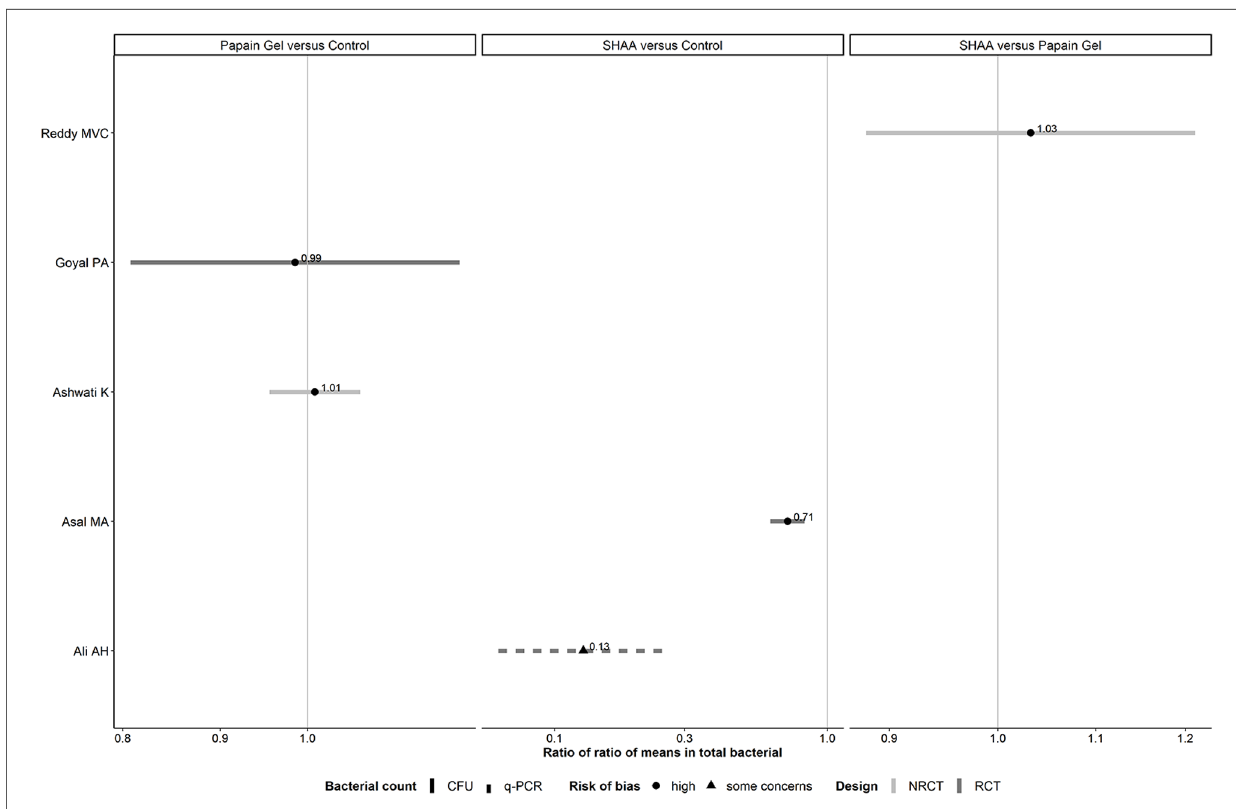
FIGURE 4 Forest plots showing roRoMs for total bacterial across chemomechanical